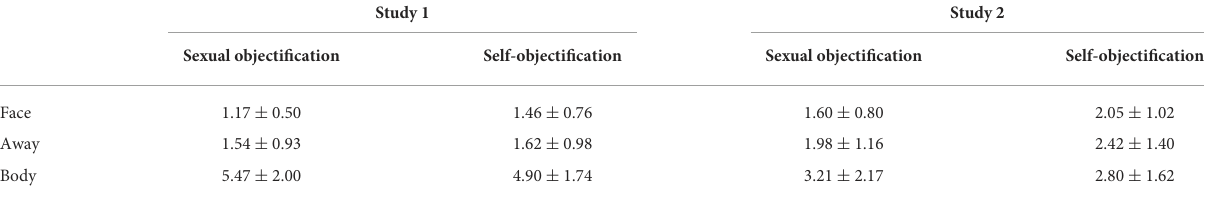
TABLE 1 Means and standard deviations of sexual and self-objectification as a function of condition (face, away, body) in Study 1 and Study